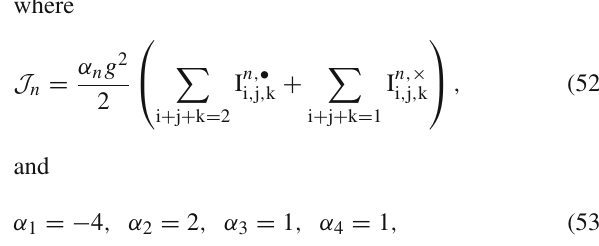
Fig. 9 The definitions of the basic graphs for the (cid:5) 2 where the symbol (cid:2) can be replaced by × or by • . The symbol ◦ denotes that the corresponding vertex does not contain the integration and it is considered at the zero. The numbers i , j , k mean the type of the propa- gator, see Fig.